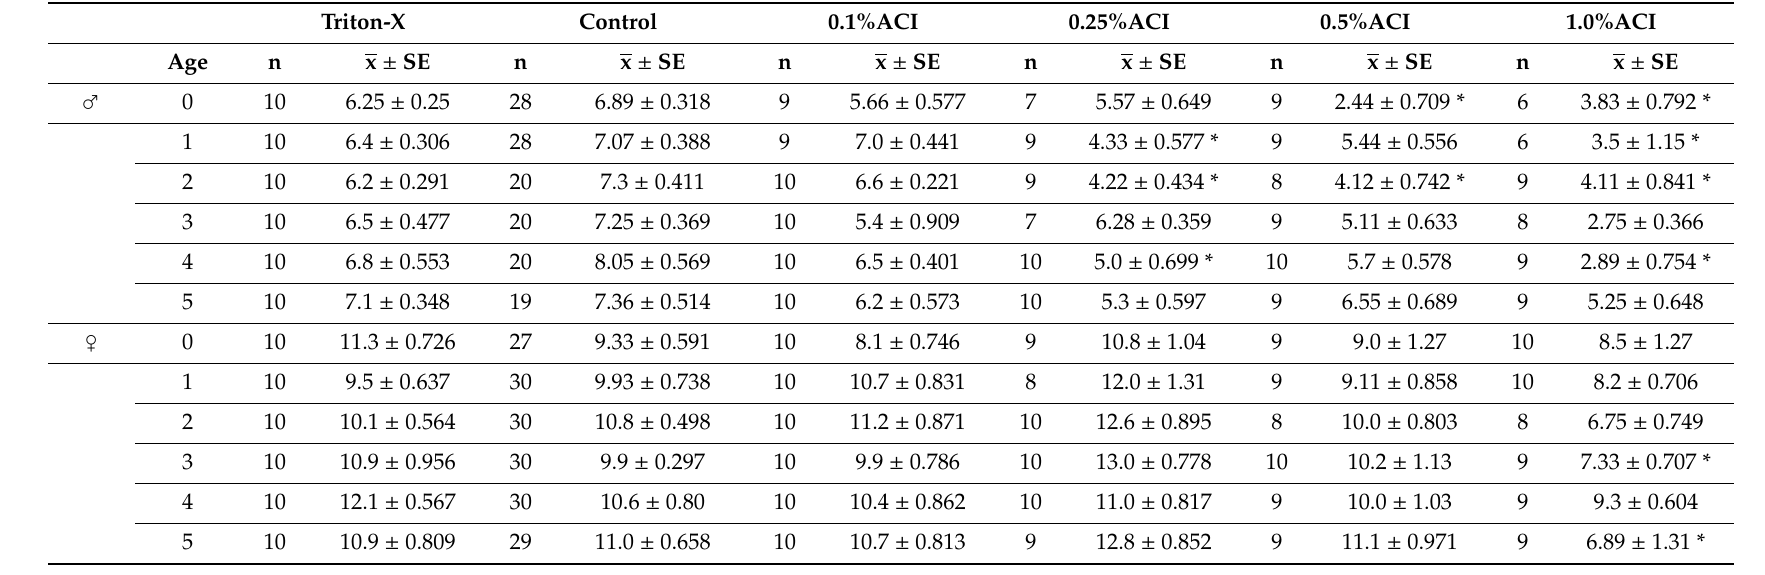
Table 6. Mean longevity of adult male and female C. fumiferana treated with tebufenozide solutions during pupal development. Age represents the number of days after pupation at which 1 µ L of a tebufenozide solution was topically applied to the individual. An ‘*’ represents a mean longevity that is significantly lower than the mean longevity of the associated control group (Tukey HSD pair-wise comparison, p <